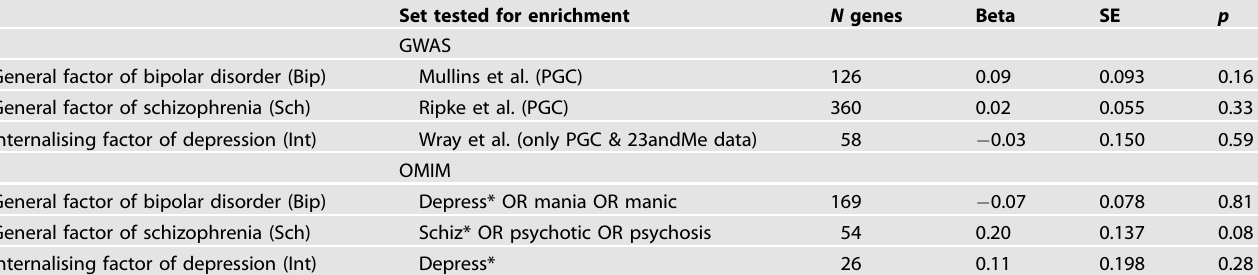
Table 2. Gene set enrichment analysis for GWAS results and Mendelian genes from